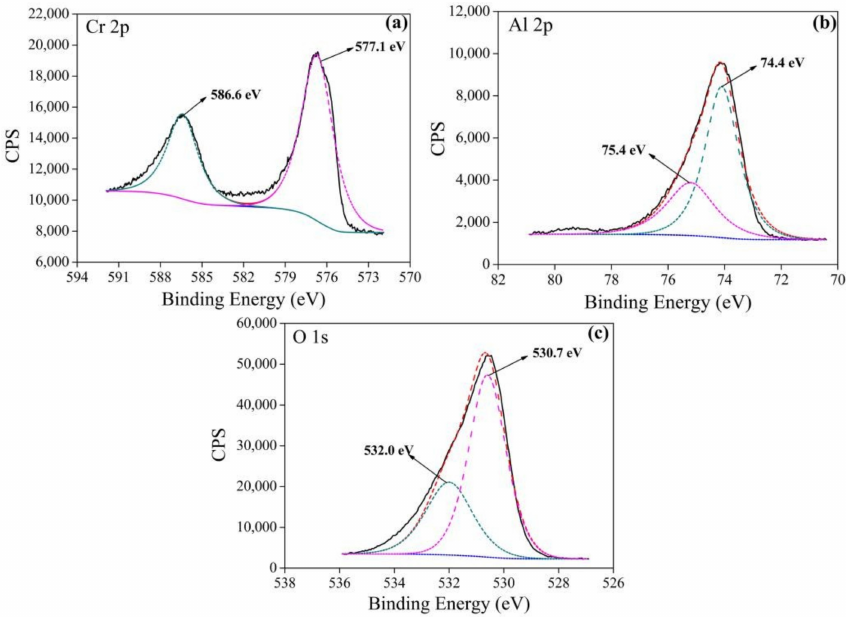
Figure 7. XPS spectra for ( a ) Cr 2p, ( b ) Al 2p, and ( c ) O 1s recorded on the sealed coating heat-treated at 750 ◦ C.